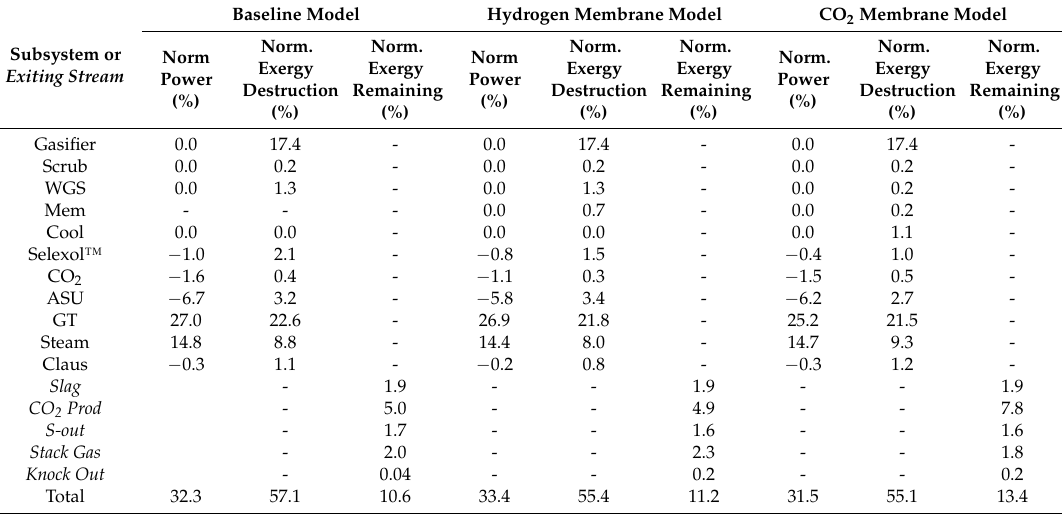
Table 11. Comparison of the normalized results of the baseline model, the hydrogen membrane model and CO 2 membrane